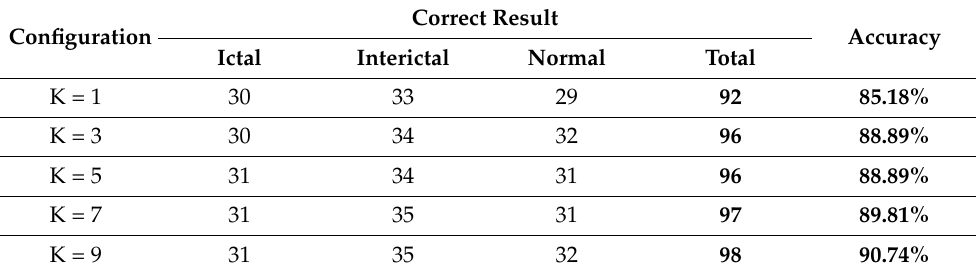
Table 1. Classification results for each K.